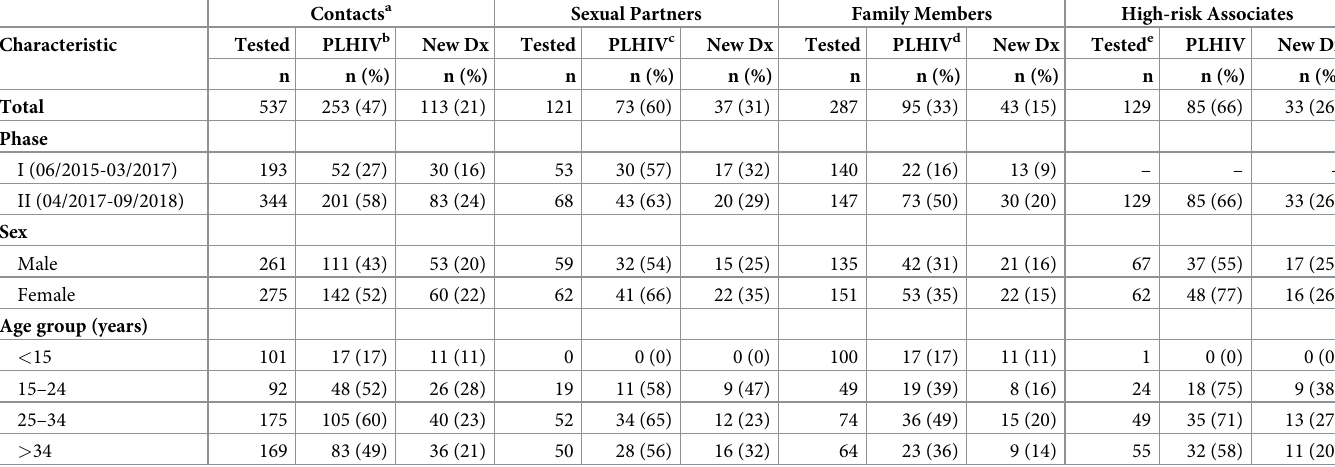
Table 2. HIV test outcomes of sexual partners, family members, and high-risk associates (contacts) of CommLink index clients, by program phase, and sex and age group, Eswatini, June 2015 –September